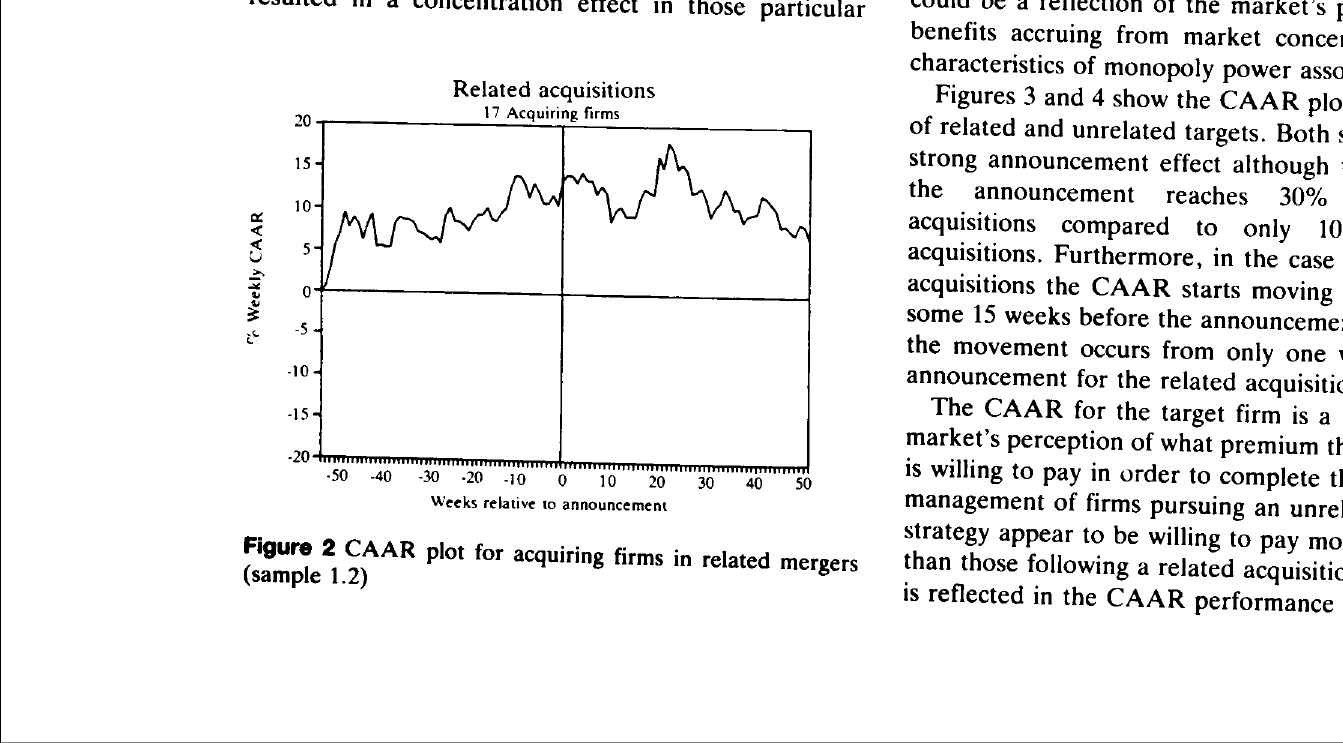
Figure 2 CAAR plot for acquiring firms in related mergers (sample 1.2)